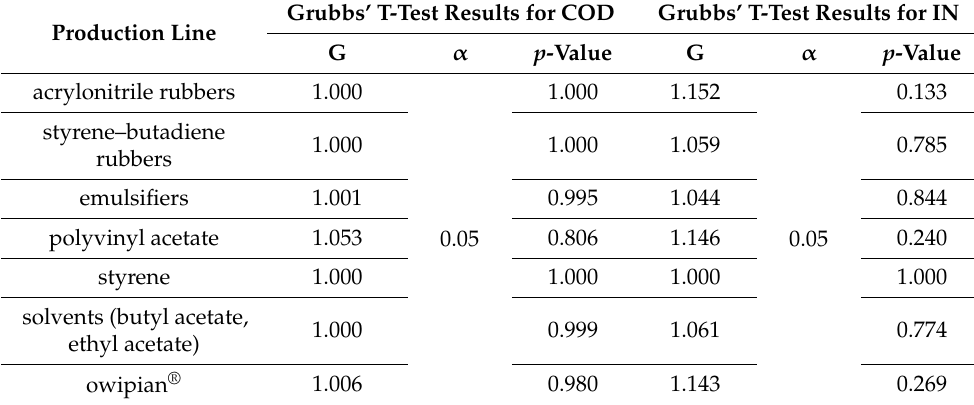
Table 3. The results of the Grubbs’ T-test for the verification of outliers in the measurement series of COD and IN values. Grubbs’ T-Test Results for COD Grubbs’ T-Test Results for IN Production Line G α p